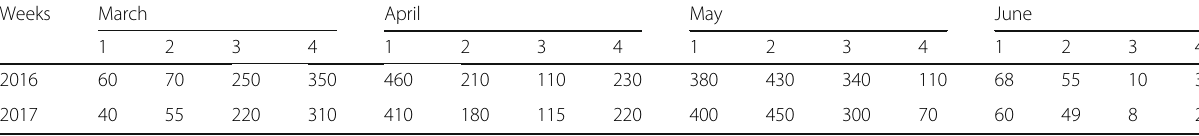
Table 2 Numbers of D. silphoides (nymphs and adults) on 25 flower or green seed bunches of Dodonaea in 2016 and 2017